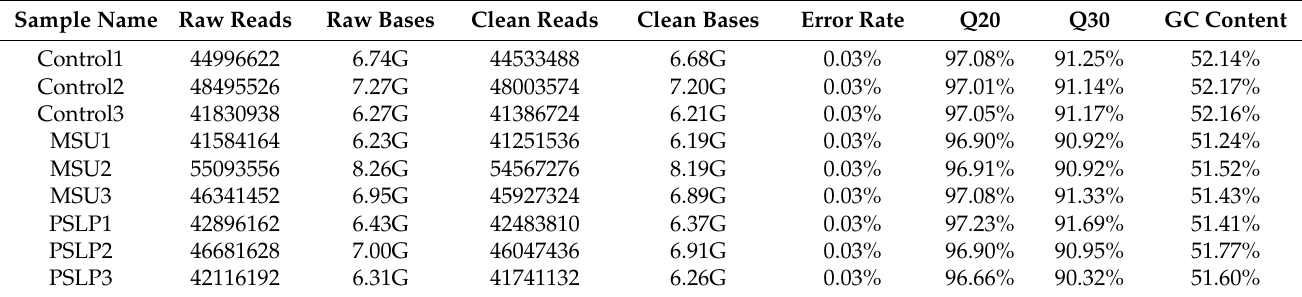
Table 2. Fluorescent quantitative PCR primer